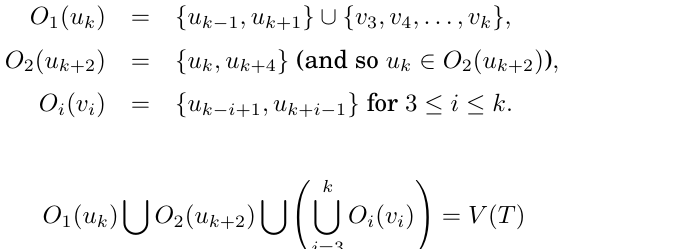
with diam( T ) = 11 and ˜ γ ( T ) = 6 6